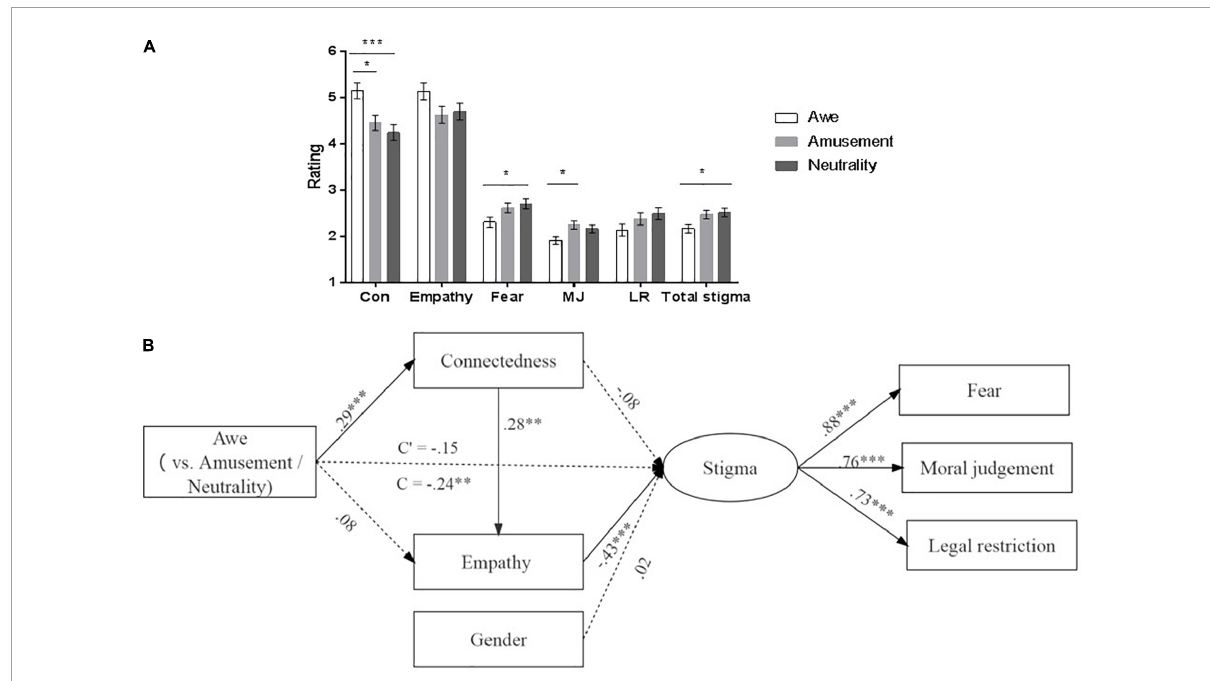
FIGURE2 The effects of emotion on measures in Study 2b. (A) Shows the means and comparisons of measures as the function of emotion. Error bars represent standard errors. (B) Is the multiple mediation model from awe to AIDS-related stigma via connectedness and empathy. The model fitting was satisfactory, χ 2 (10) = 15.79, p = 0.106, CFI = 0.98, NFI = 0.95, GFI = 0.98, RMSEM = 0.06. Con, connectedness; MJ, moral judgment; LR, legal restriction. Dummy variable code: awe group = 1, neutral group = amusement group = 0; male = 1, female = 2. ∗ p < 0.05, ∗∗ p < 0.01, ∗∗∗ p <